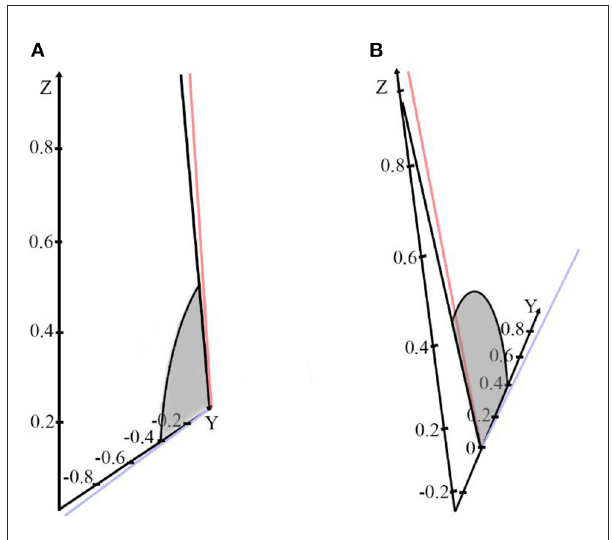
FIGURE2 (A) The horizontal semicircular canal normal vector is rotated 73.8 ◦ clockwise around the X-axis to the XY plane. (B) The normal vector of the horizontal semicircular canal is rotated 106.17 ◦ counterclockwise around the X-axis to the XY plane.